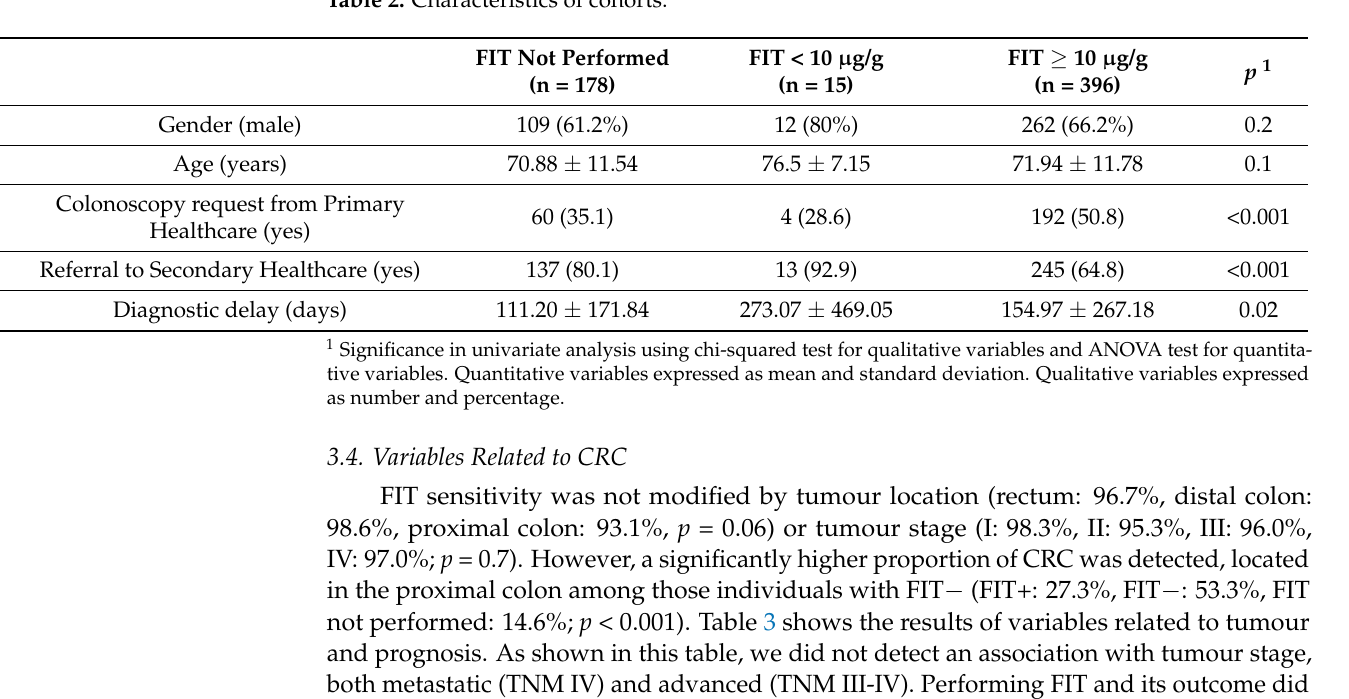
Table 2. Characteristics of cohorts.